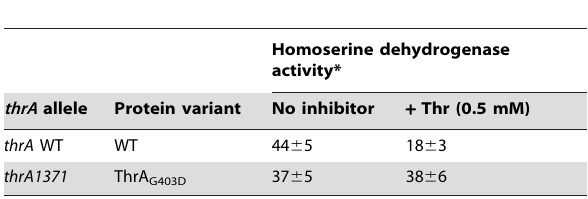
Table 3. The ThrA G403D variant is insensitive to feedback inhibition by threonine and